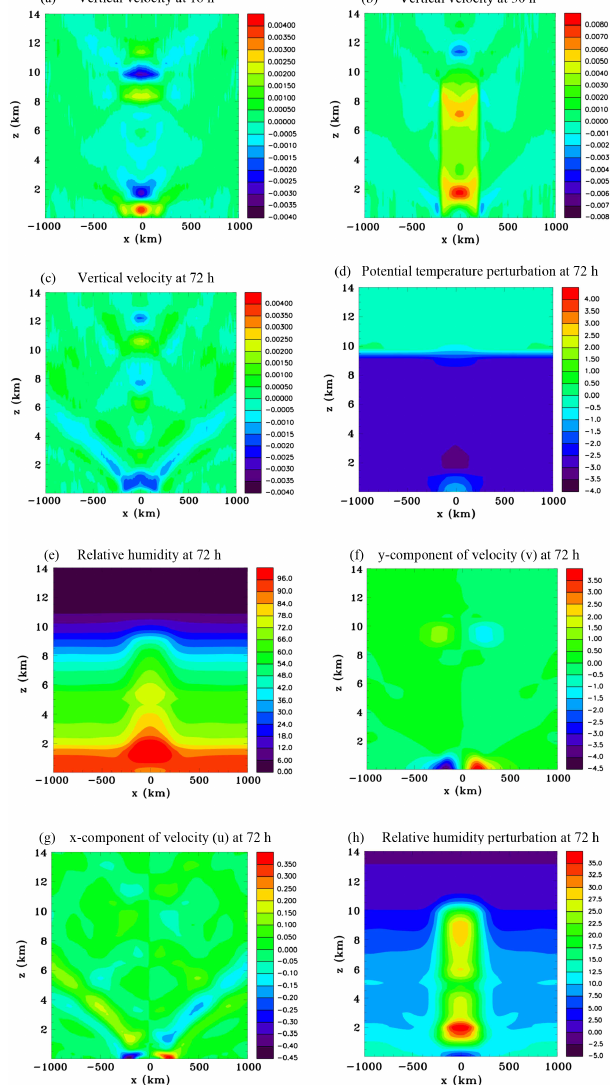
Figure 9. Vertical sections for Experiment 7: the idealized diurnal forcing case. (a) Vertical velocity at t = 18h (ms − 1 ), (b) vertical velocity at t = 30h (ms − 1 ), (c) vertical velocity at t = 72h (ms − 1 ), (d) potential temperature perturbation at t = 72h (K), (e) relative humidity at t = 72h, (f) y-component of velocity, v at t = 72h (ms − 1 ), (g) x-component of velocity, u at t = 72h (ms − 1 ), and (h) relative humidity perturbation at t =